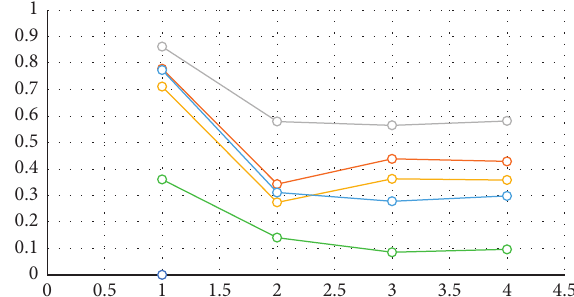
Figure 3: The graphical portrayal of the interpreted SMs between ( J � 1 , 2 , 3 , 4 ) . P and D J